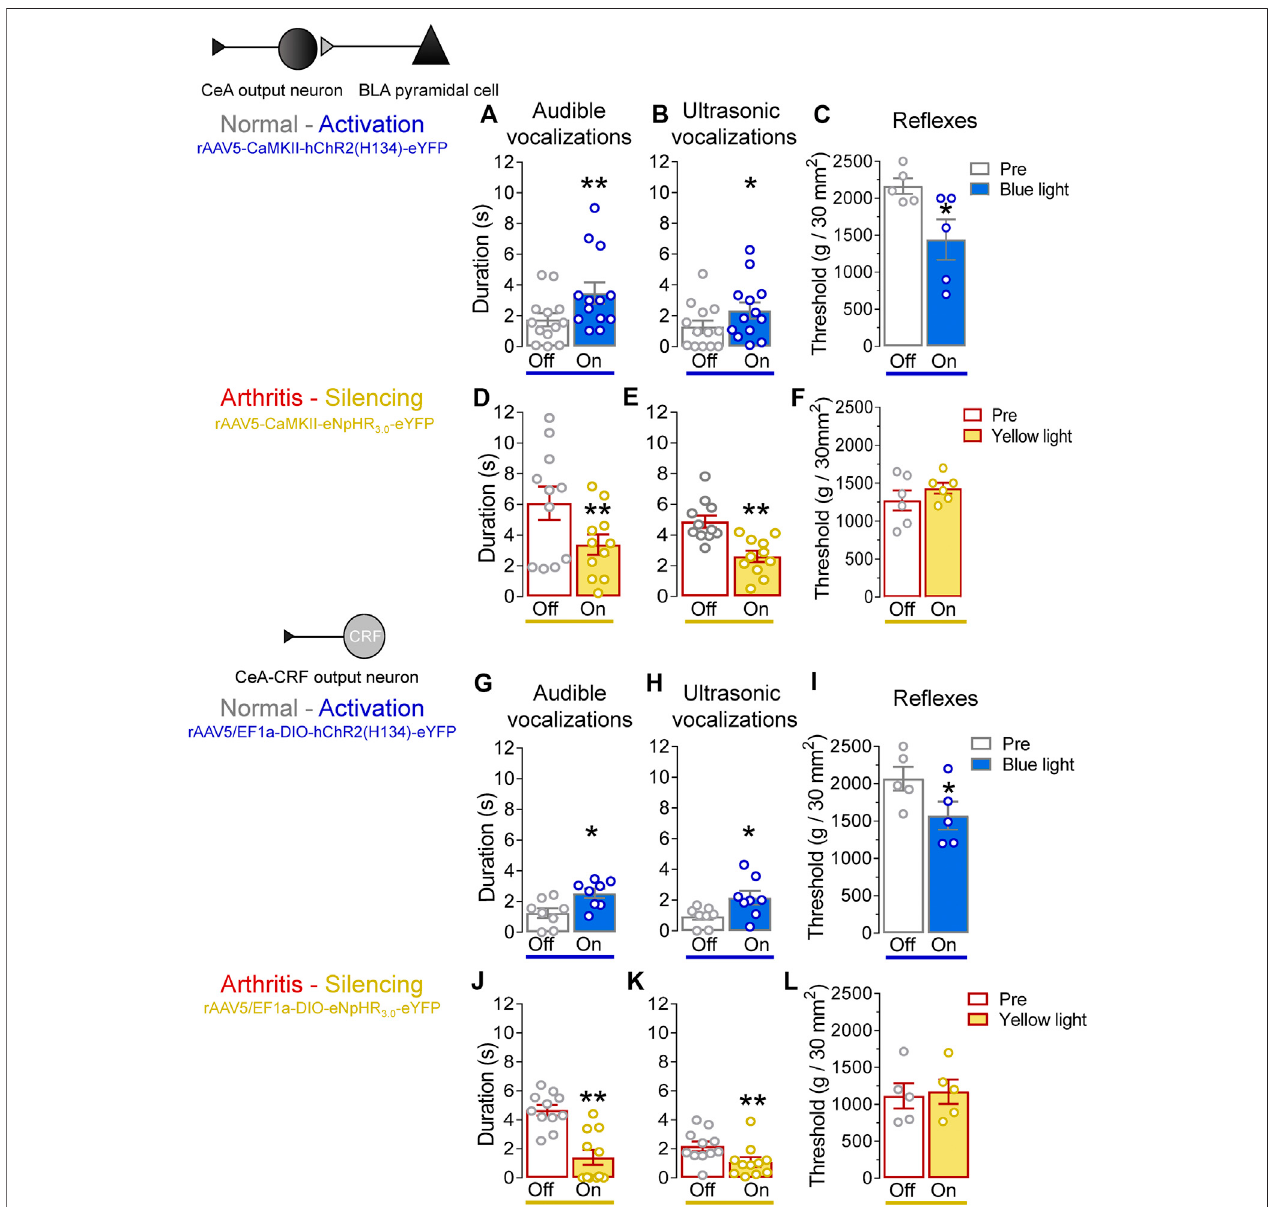
FIGURE6| Effectsofoptogeneticamygdalamanipulationsonpain-related behaviorsinnormalandarthritisconditions. (A) Audibleand (B) ultrasonicvocalizations evoked by noxious compression of the knee joint with a calibrated forceps were signi fi cantly increased by the activation of ChR2 on BLA – CeA terminals with blue (473 nm) light application ( “ On ” , 20 Hz, 5 mW, 5 – 10 min) into the CeA compared to no light ( “ Off ” ) values in normal naïve rats ( n (cid:1) 13). (C) Mechanical withdrawal thresholds were signi fi cantly reduced by blue light (473 nm) exposure in normal naïve rats ( n (cid:1) 5), indicating hypersensitivity. (D – F) Same display as (A – C) but for silencing of eNpHR 3.0 expressing BLA – CeA terminals with yellow light (590 nm) in arthritic rats (audible and ultrasonic vocalizations, n (cid:1) 11; re fl exes, n (cid:1) 6). (G – I) Same display as (A – C) but for activation of ChR2 expressing CeA – CRF neurons in normal naïve transgenic rats (audible and ultrasonic vocalizations, n (cid:1) 8; re fl exes, n (cid:1) 5). (J – L) Same display as (A – C) but for silencing of eNpHR 3.0 expressing CeA – CRF neurons with yellow light (590 nm) in arthritic transgenic rats (audible and ultrasonic vocalizations, n (cid:1) 11; re fl exes, n (cid:1) 5). *, ** p < 0.05, 0.01 compared to no light ( “ Off ” ) values, paired t – test.